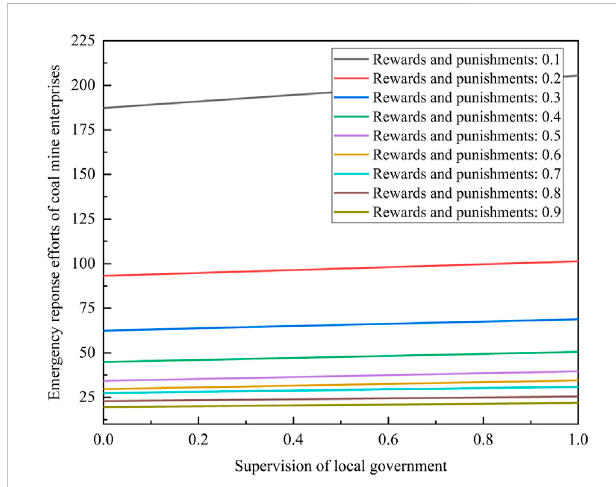
FIGURE 4 The relationship between emergency response efforts of coal mining enterprises and government supervision under different rewards and punishments.